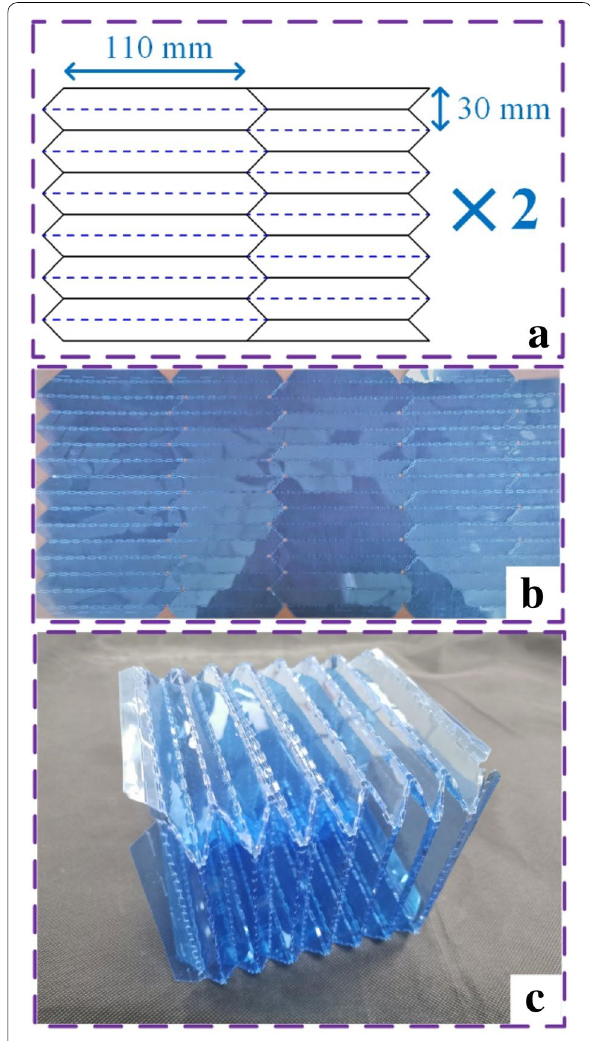
Figure 4 Origami shell: base crease pattern, 2D laser-cut film and folded 3D